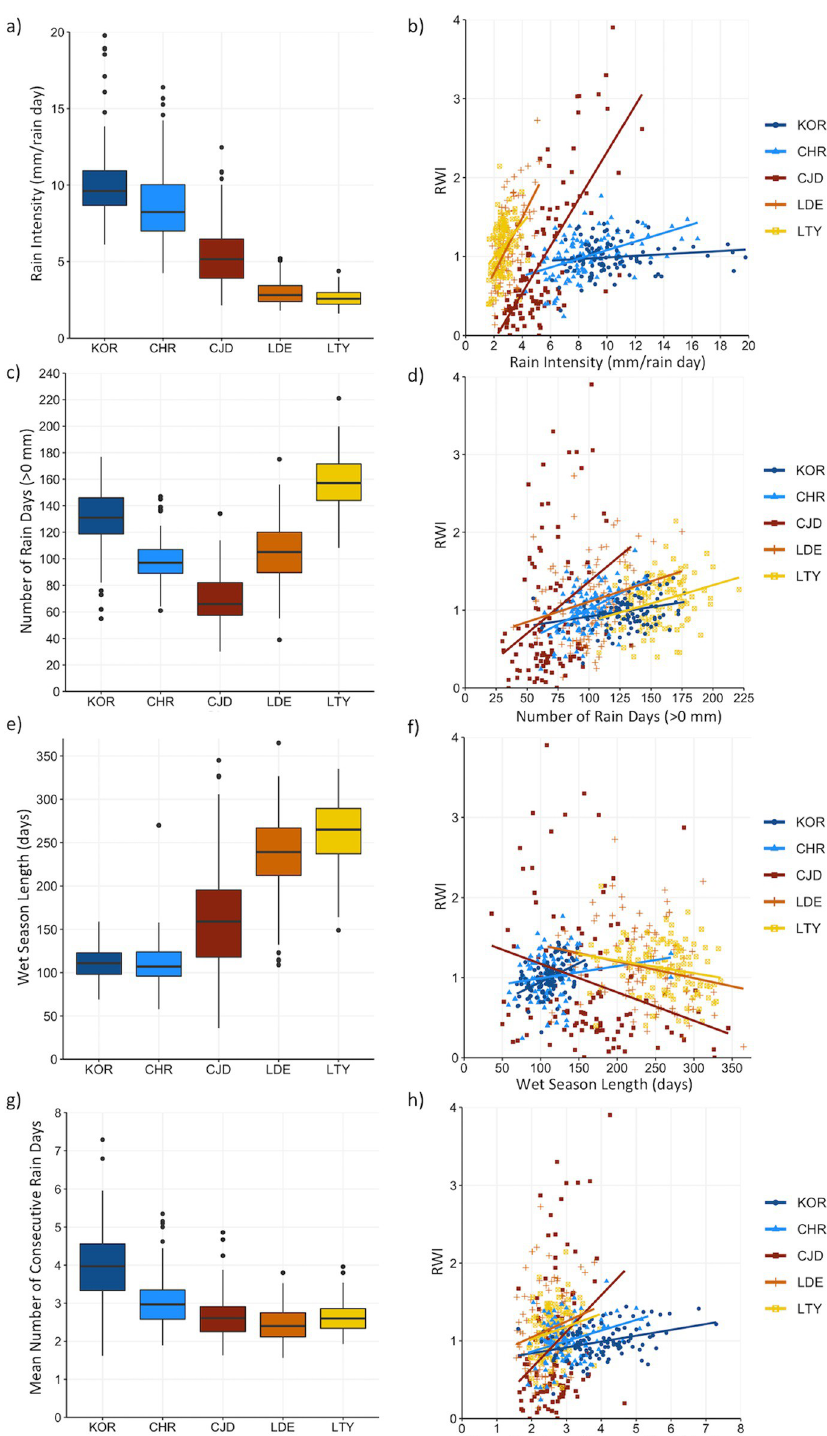
Fig 4. Distribution of annual rainfall attributes and their relationship with Ring Width Index (RWI) of Callitris columellaris across semi-arid (yellow-red) and tropical (blue) biomes in Australia. (a-b) mean rain intensity (mm/ rain day), (c-d) number of rain days ( > 0 mm), (e-f) length of wet season (number of days) and (g-h) mean number of consecutive rain days ( > 0 mm). Boxplots show the median (50th percentile) as the centre horizontal line, the interquartile range (25th to 75th percentile) as the bottom and top horizontal line, the range (0.3–99.7th percentile) as